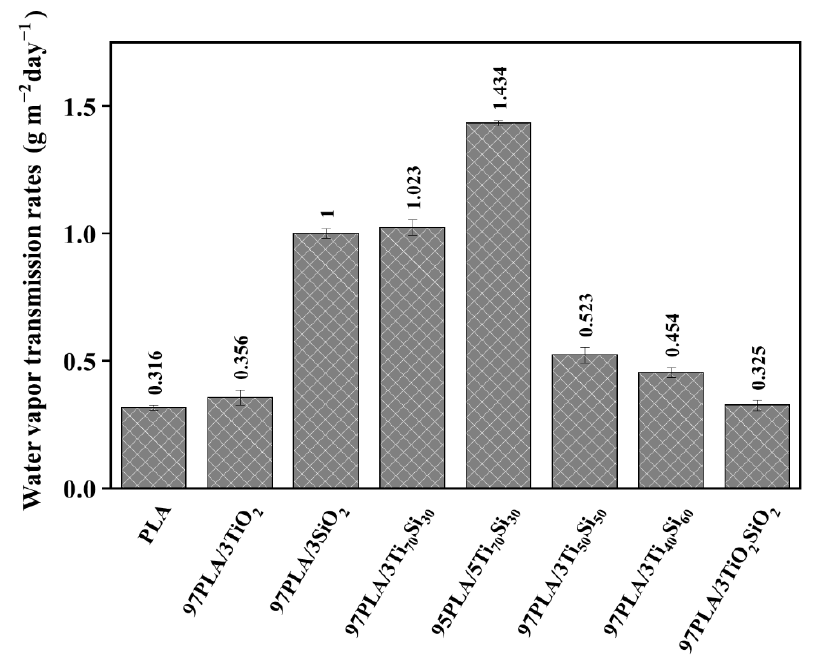
Figure 7. Water vapor transmission rate (WVTR) of PLA, PLA/TiO 2 , PLA/SiO 2 , PLA/Ti x Si y , and PLA/TiO 2 SiO 2 composites .